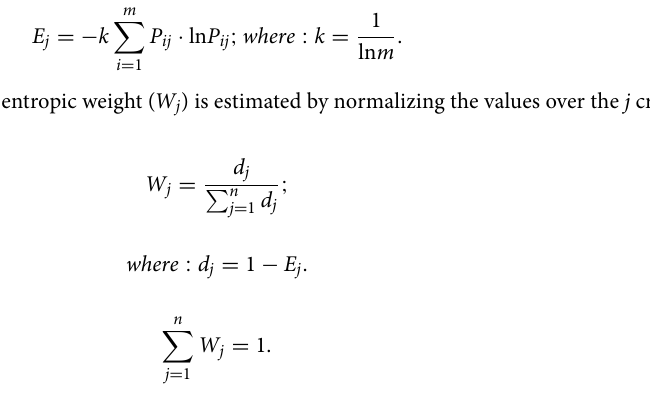
Table 3. Rationale of chosen vulnerability indicators and assigned Fuzzy